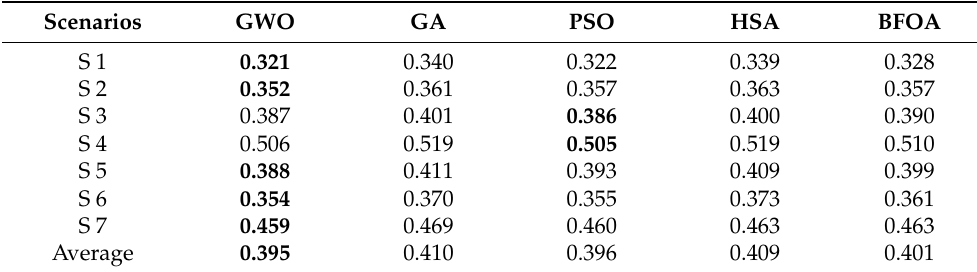
Table 16. Comparison between the five algorithms in terms of CPR reduction.